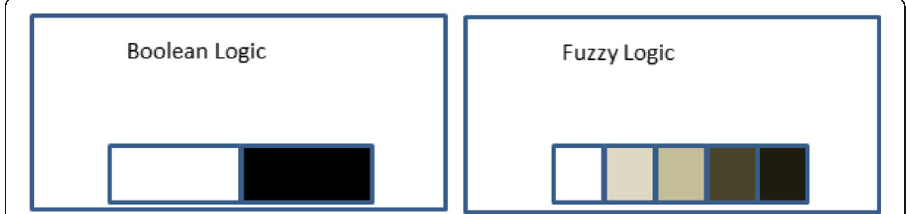
Fig. 8 Boolean logic and Fuzzy logic. This Fig illustrates the difference between Aristotelian/Boolean and fuzzy logic. Aristotelian logic has defined border between zero and one but Fuzzy logic does not have defined border. It is a range between zero and